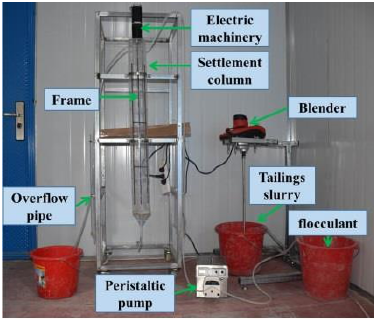
Figure 2. Thickening test platform.